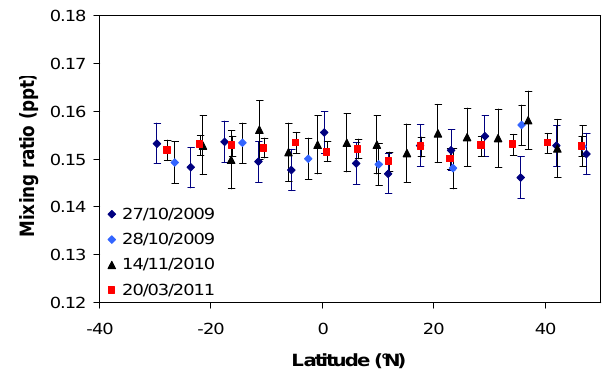
Fig. 4. Measurements of SF 5 CF 3 from whole air samples collected from four interhemispheric CARIBIC flights flying at 8.6–12.2km, as a function of